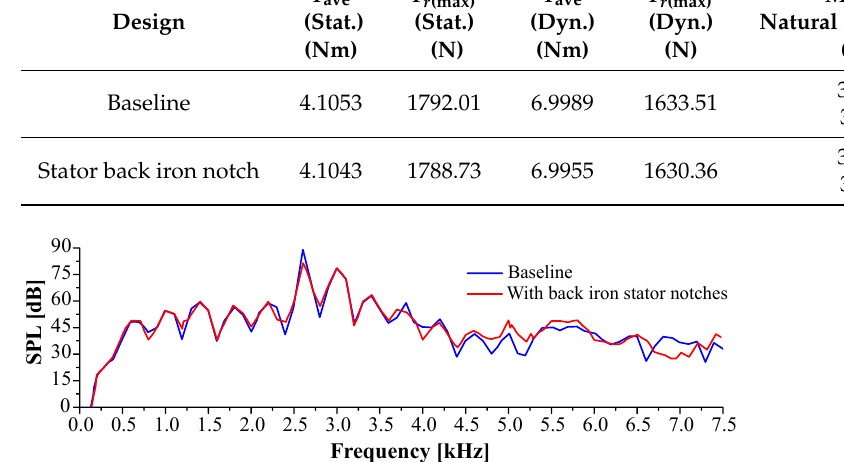
Figure 18. SPL comparison for the notched stator back iron